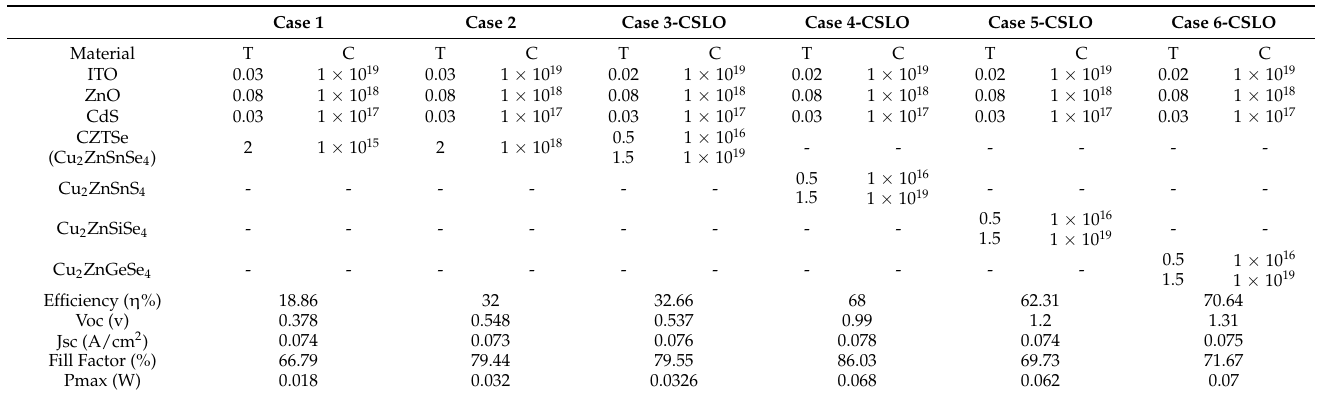
Table 2. Thickness (T) micro meter and doping concentration (C)-change